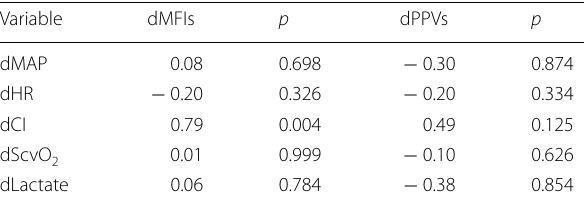
Table 3 Correlations of changes in MFI and PPV of small vessels with changes in hemodynamic parameters during the first RIC